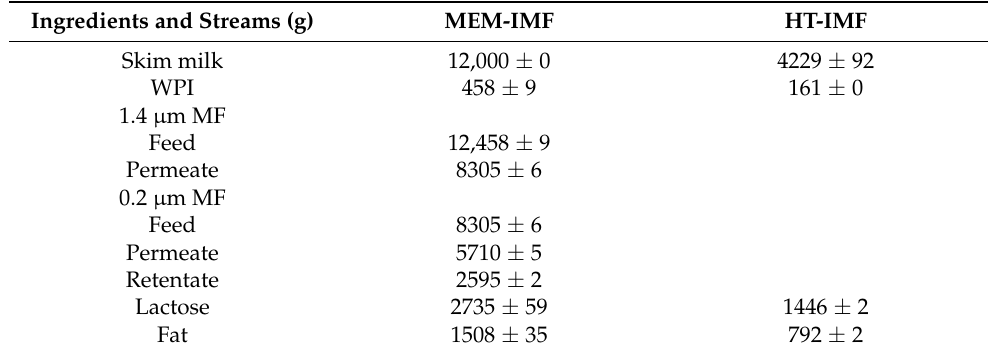
Table 2. Average mass (in g) of ingredients for processing membrane-filtered infant milk formula (MEM-IMF) and high-heat-treated infant milk formula (HT-IMF). Ingredients and Streams (g)